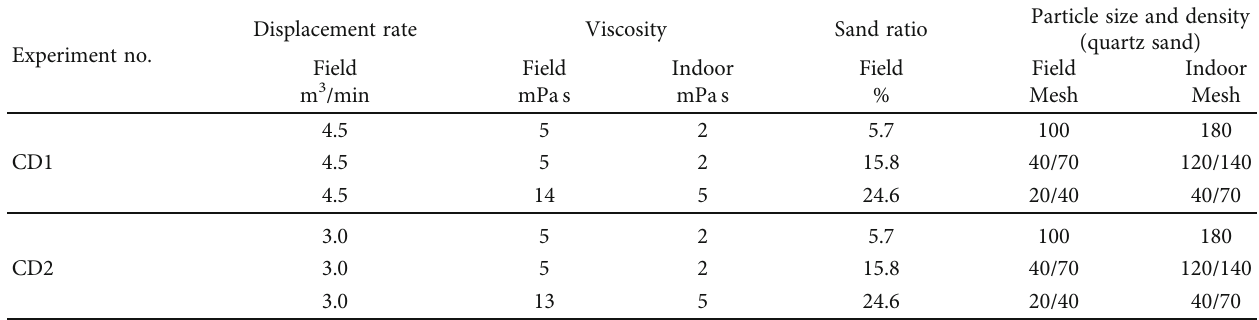
Table 3: Displacement rate exploration experiment scheme of LD C7. Experiment